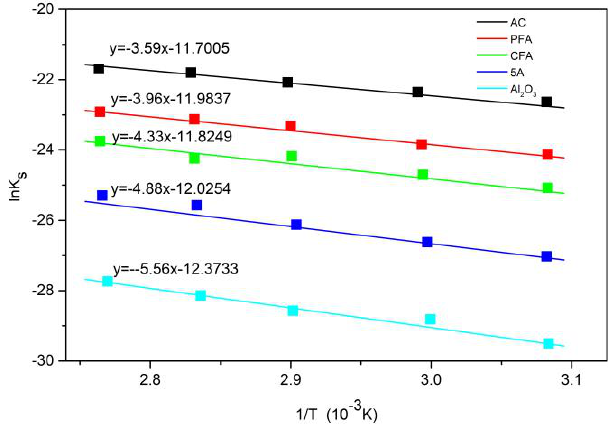
Figure 12. Arrhenius relational fitting diagram for a chemical reaction control phase.